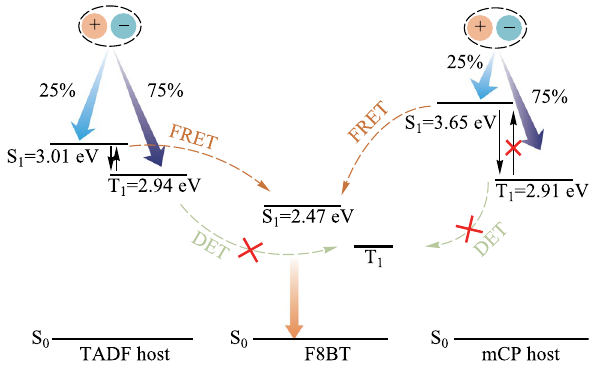
Fig. 6 Schematic illustration of energy transfer respectively from the TADF host and the conventional fluorescent host mCP to the fluores- cent polymer guest